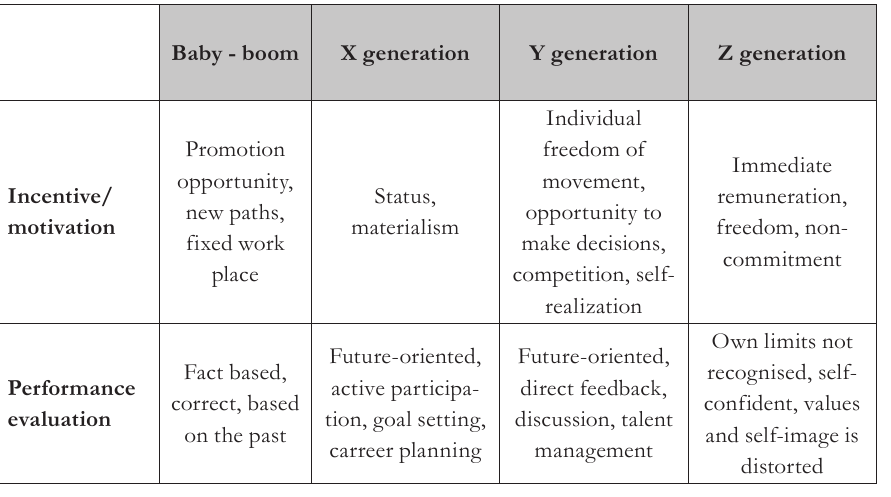
Tab. 3 - Challenges of the HR in the light of different generational characteristics Source: Bencsik & Machova,